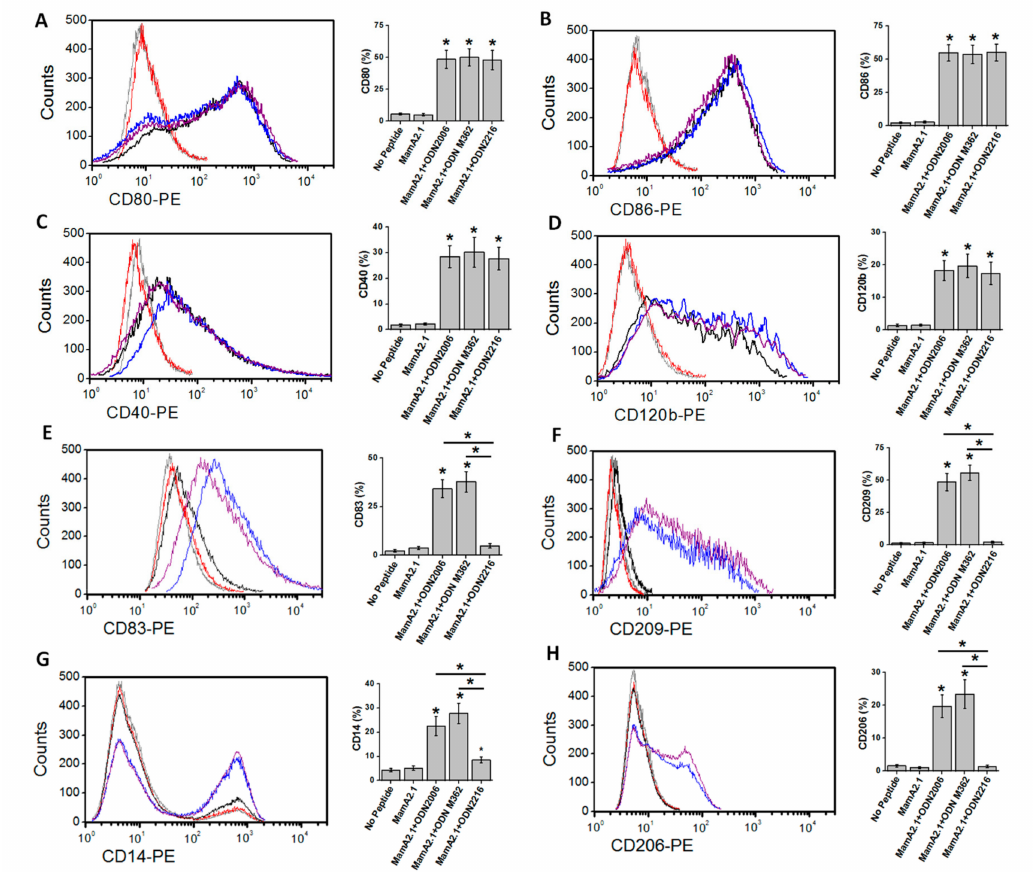
Figure 3. Expression of phenotypic markers on THP-1 cells following treatment with ODNs. The various treatment conditions were: (light gray) no peptide—regular culture conditions; (red) MamA2.1 peptide alone; (magenta) MamA2.1 + ODN2006; (blue) MamA2.1 + ODN M362; and (black) MamA2.1 +